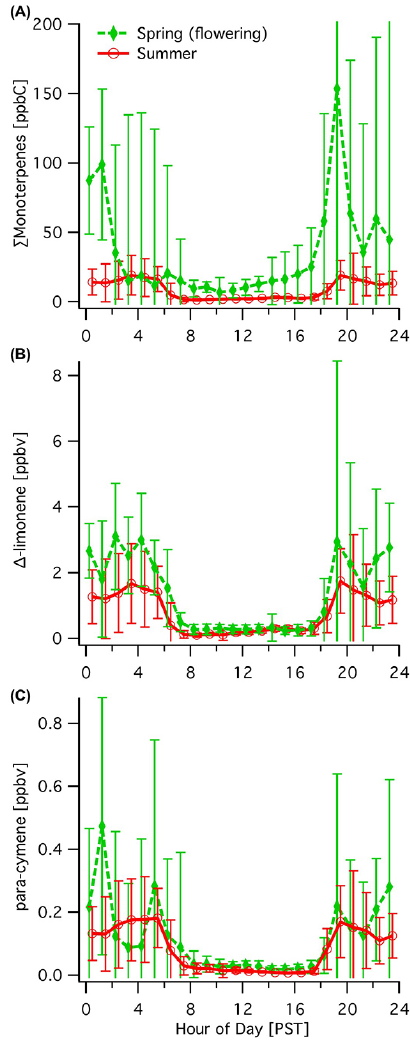
Figure 5. Seasonal comparison of diurnal concentration patterns for ( A) total monoterpenes, (B) 1 -limonene, and (C) p -cymene, shown with standard deviations. The seasonal comparison of 1 -limonene and p -cymene concentrations demonstrates similar seasonal abun- dances that are slightly higher during